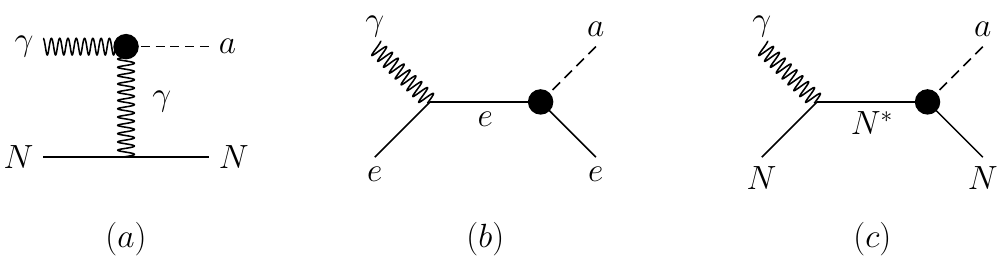
Figure 2 . ALPs production mechanisms at a nuclear reactor plant. Process ( a ) corresponds to Primakoff photon-ALP conversion, process ( b ) to Compton-like scattering and process ( c ) to nuclear de-excitation. Depending on the type of SM-ALP coupling ( g nucleons), in addition to the processes shown in figure 1, photons interacting with the reactor fuel can be subject to these processes.